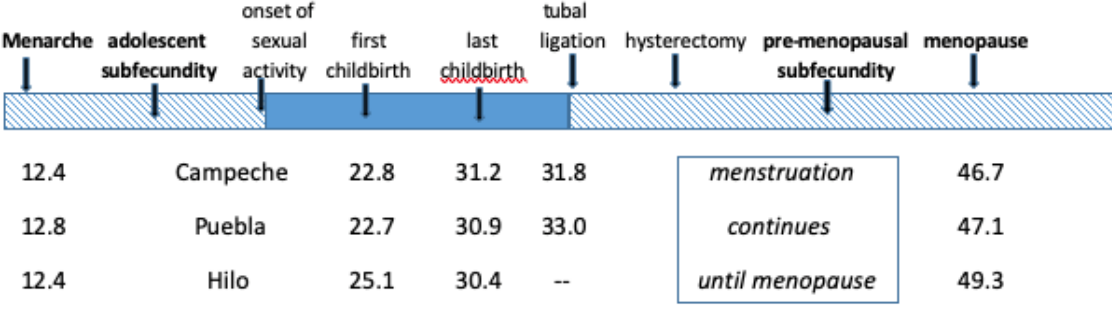
Figure 2: Tubal ligation as the end of fertility: timeline showing mean recalled ages (in years) at menarche, first childbirth, last childbirth, tubal ligation, and menopause in Campeche, Puebla, and Hilo. Dark blue indicates fertile period.